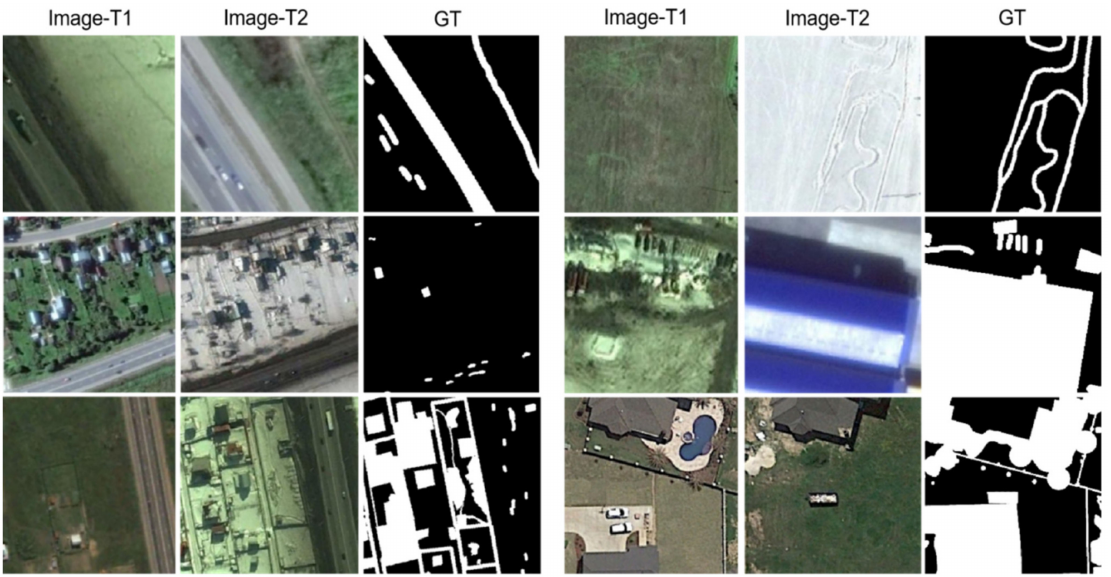
Figure 5. Illustration of samples from CDD. (Image-T1) and (Image-T2) indicate the bi-temporal image pairs. (GT) indicates the ground truth.